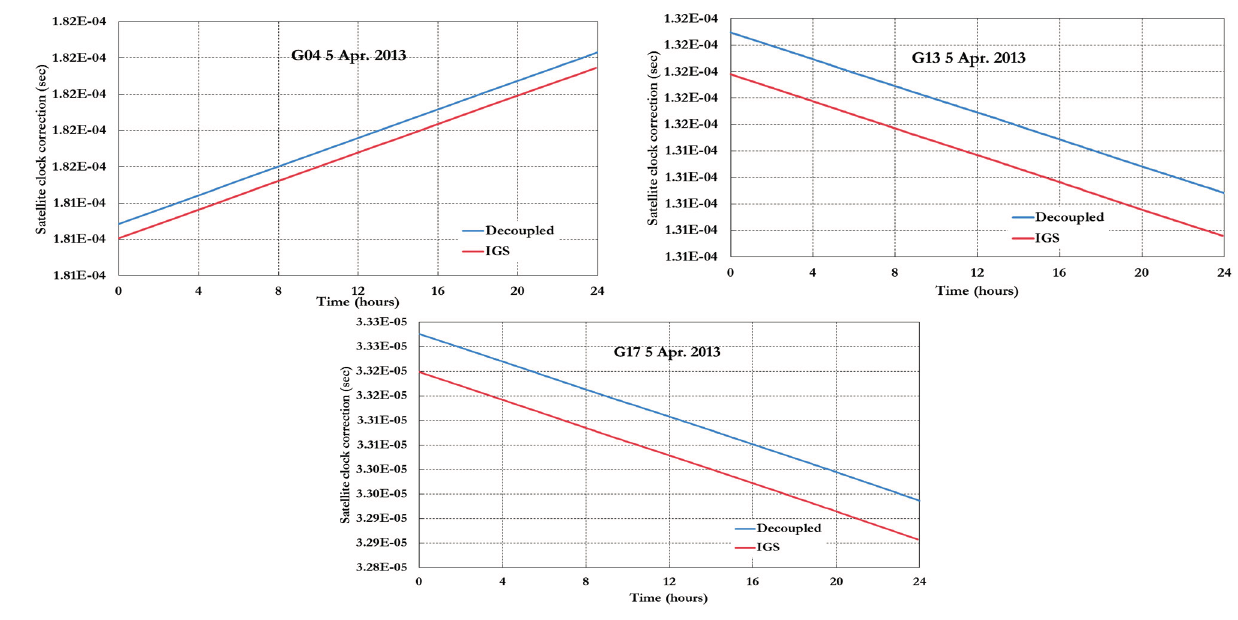
Figure 5. IGS and decoupled clock corrections 5 April